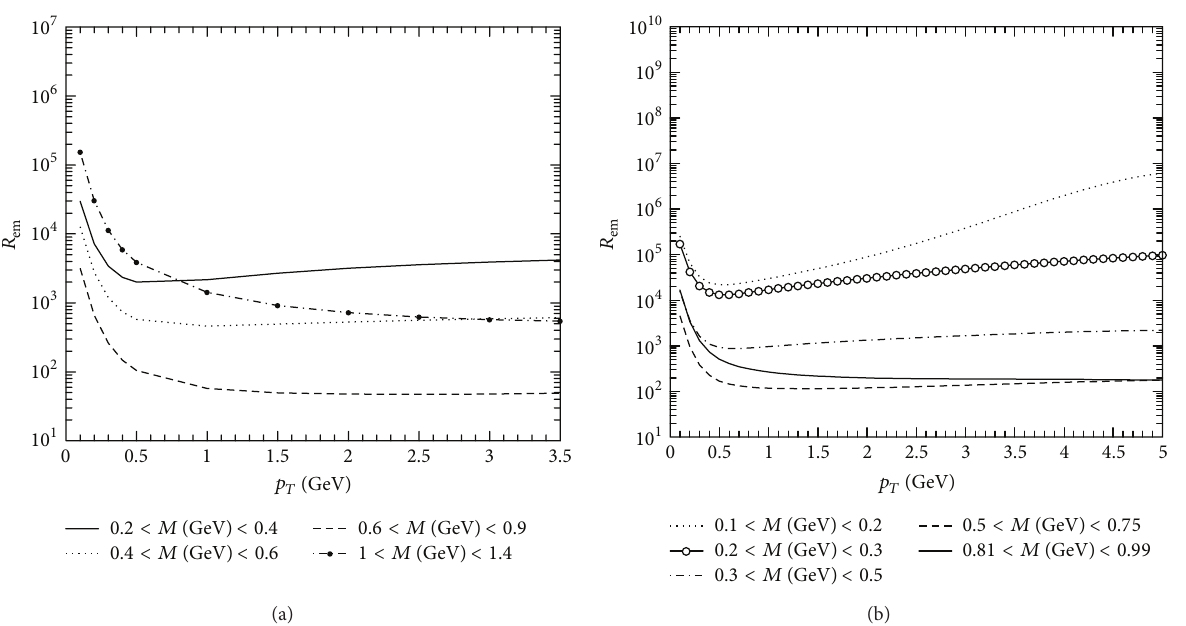
, with 𝑝 𝑇 for different invariant mass windows at SPS energy (a) and RHIC energy em